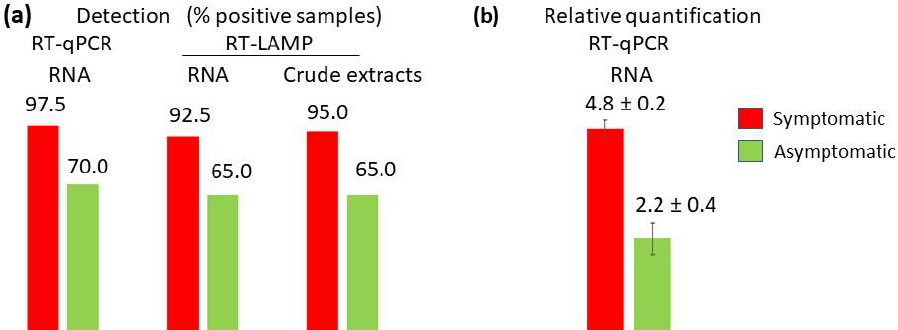
Figure 4. Analysis of leaves from symptomatic and asymptomatic C. esculentus plants collected in the field: ( a ) percentage of positive samples; ( b ) relative quantification expressed in a logarithm scale.